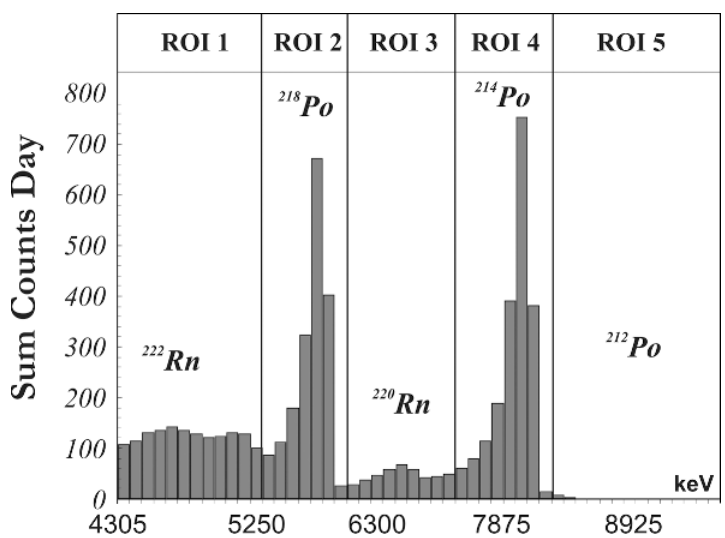
Figure 2: Distribution of the alpha-decay measurements obtained at the summit real-time station (PZZ) with the DOSEMan radonmeter starting from April